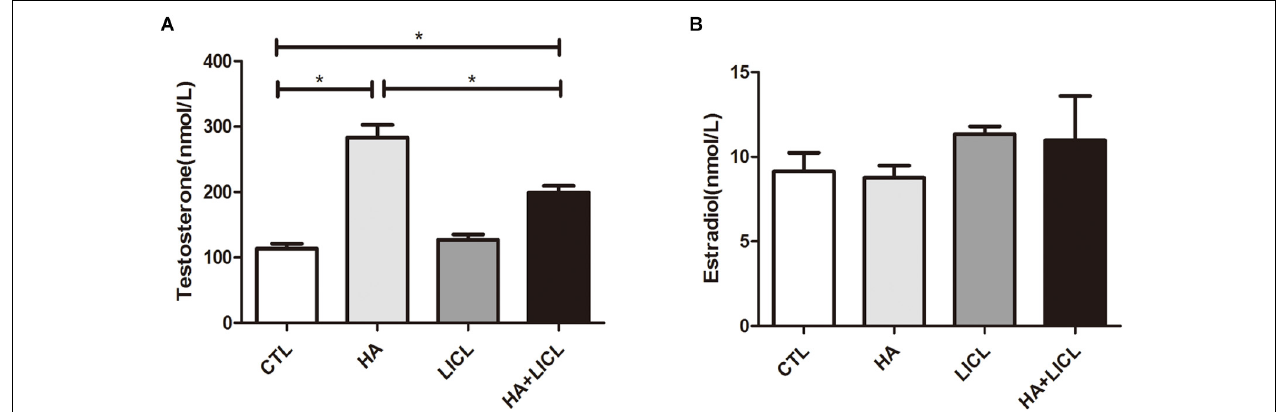
FIGURE 1 | Higher levels of serum testosterone in pregnant rats after letrozole treatment. (A) Pregnant rats in the HA and HA+LICl groups ( n = 6) had higher levels of serum testosterone as compared to the CTL group ( n = 6), (B) There was no significant difference in serum estradiol levels among the four groups. ∗ p <